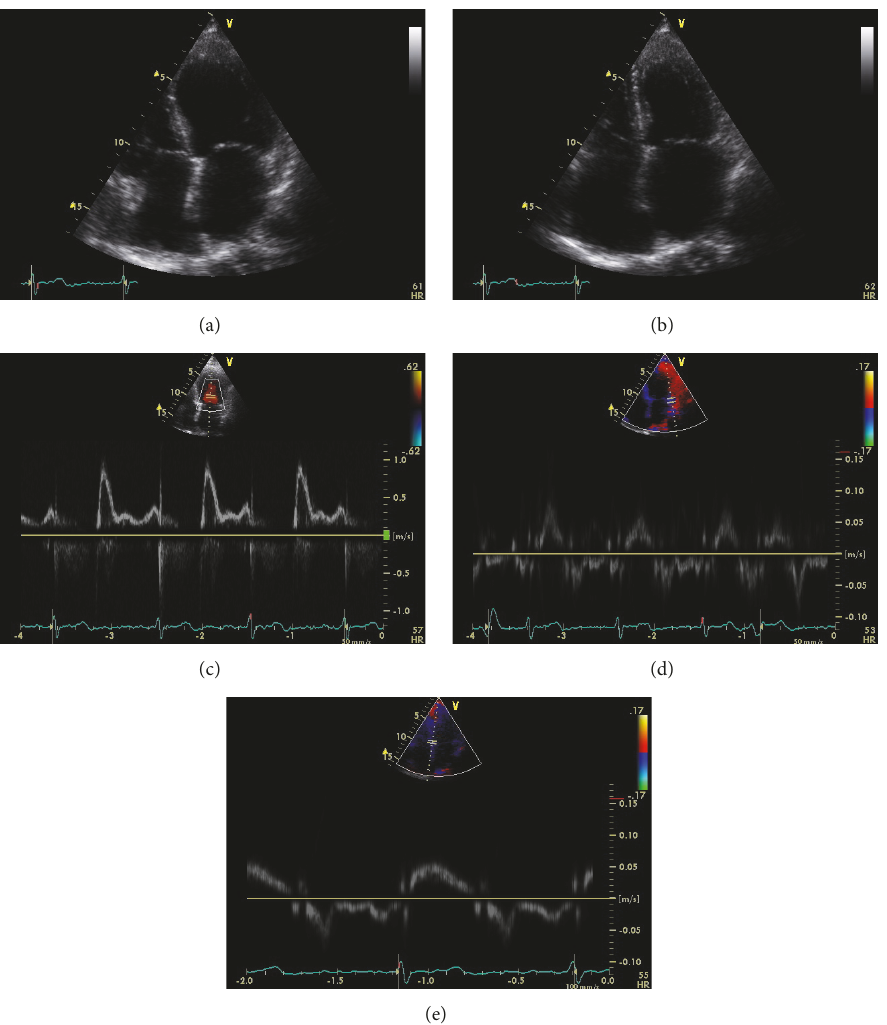
Figure 1: Echocardiographic images from a patient with restrictive cardiomyopathy. Two-dimensional 4-chamber view in diastole (a) and systole (b), showing normal left ventricular volume, wall thickness, and systolic function (EF 62%). There is marked biatrial enlargement. Pulse wave Doppler from the left ventricular inflow (c) showing restrictive filling pattern with an E wave velocity of 1m/sec, an A wave velocity of 0.4 m/sec, and an E wave deceleration time of 145msec. Spectral tissue Doppler from the lateral (d) and septal (e) mitral annulus. There is marked reduction in systolic annular velocities indicative of latent systolic dysfunction. E / e 󸀠 ( e 󸀠 measured as the average between the two annular e 󸀠 velocities) is 16, indicative of increased left ventricular filling pressure. Note the marked reduction in lateral a 󸀠 velocity ( < 4cm/sec) indicative of left atrial systolic